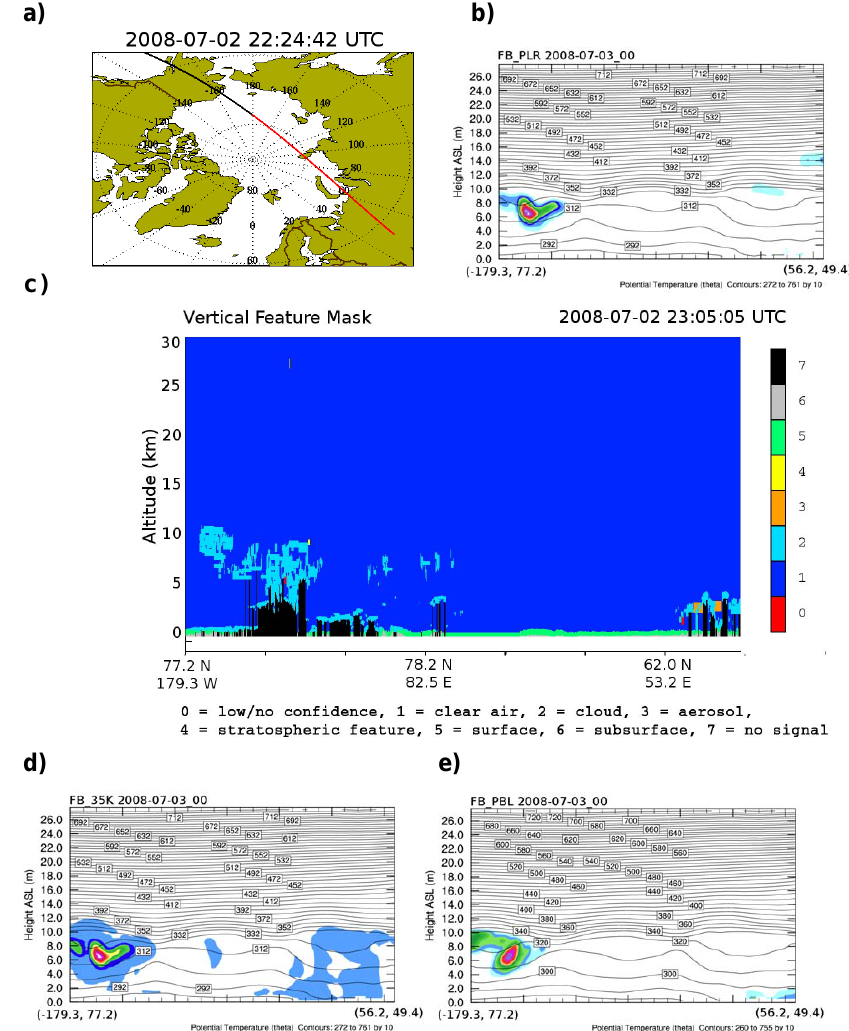
Fig. 13. (a) Map of CALIPSO path at 2224 UTC 2 July 2008 with analyzed segment near the North Pole in red and (c) the CALIOP vertical feature mask (VFM). Normalized WRF aerosol plumes for (b) FB PLR, d) FB 35K, and (e) FB PBL along the CALIPSO